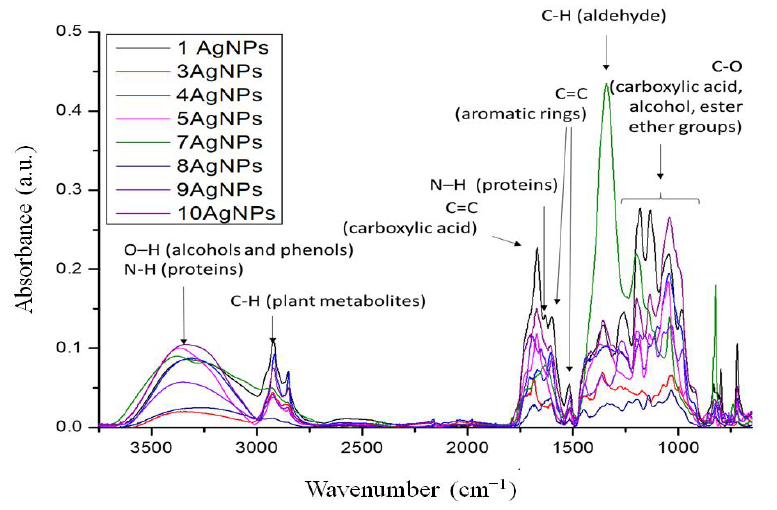
Figure 4. FTIR spectra in the range 4000–650 cm − 1 of AgNPs synthesized in presence of extracts from: 1- Aegopodium podagraria , 3-Salvia officinalis, 4- Tilia cordata , 5- Viscum album , 7- Porphyra Yezoensis , 8- Camellia sinensis, 9- Ilex paraguariensis , and 10 -Levisticum officinale.